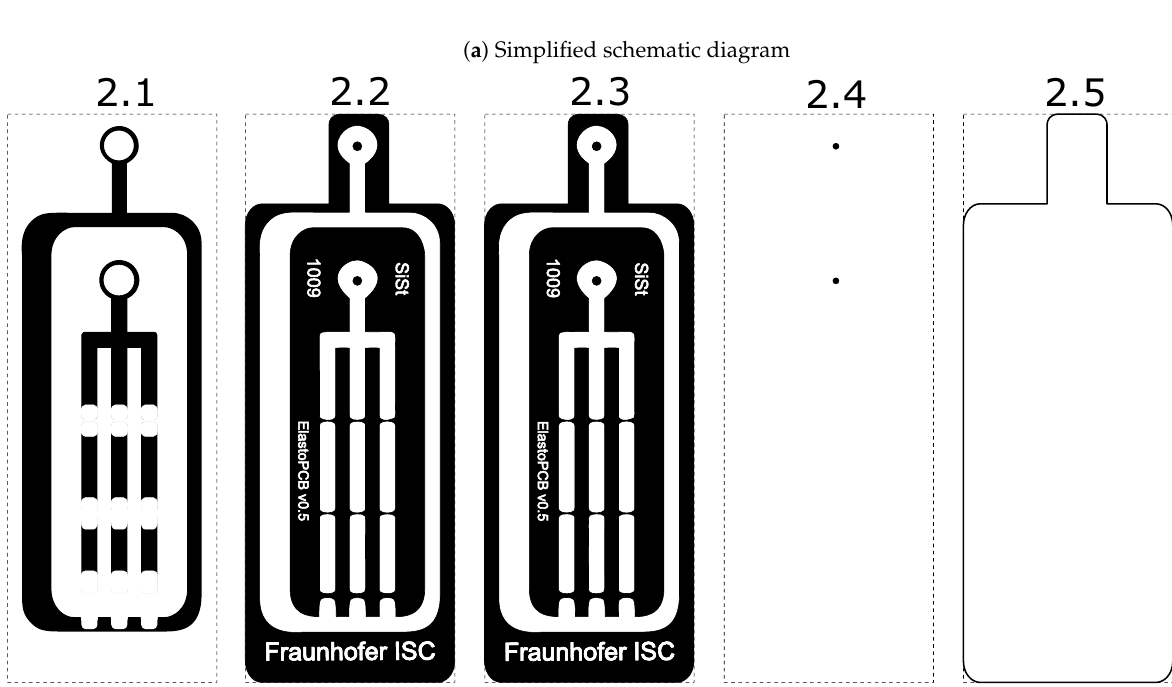
Figure 1. Simplified schematic diagram of the coating and laser structuring steps for manufacturing a single-conductor-layer circuit board (drawing not to scale). For the purpose of clarity, the schematic cross-sectional view shown in ( a ) does not show the actual structure, but only three representative elements (a through-hole plating, an SMD connection and an expandable area in between). The top view in ( b ), in contrast, shows the actual layer